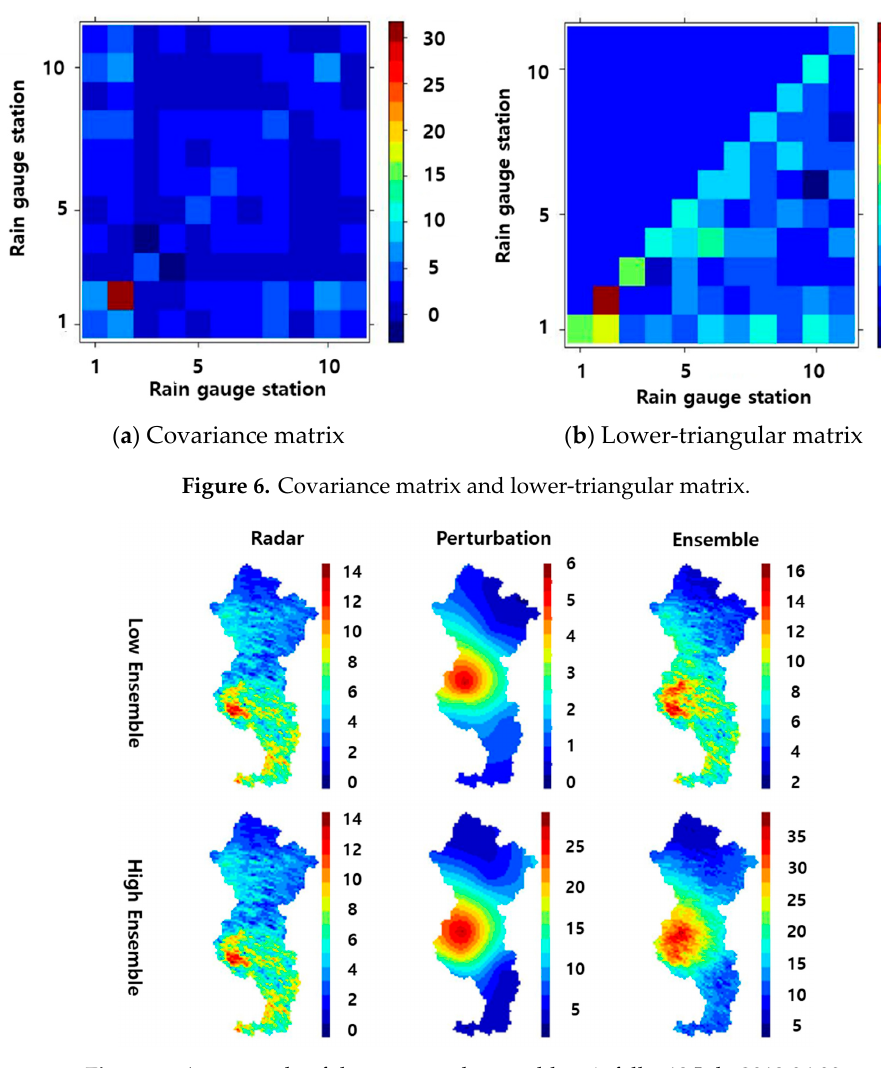
Figure 7. An example of the generated ensemble rainfall—13 July 2013 06:00.